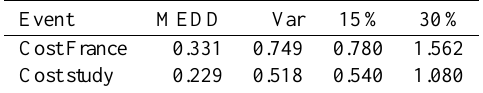
Table 5. Expected costs of floods under climate change for different loss types, downscaling techniques and years, in billion